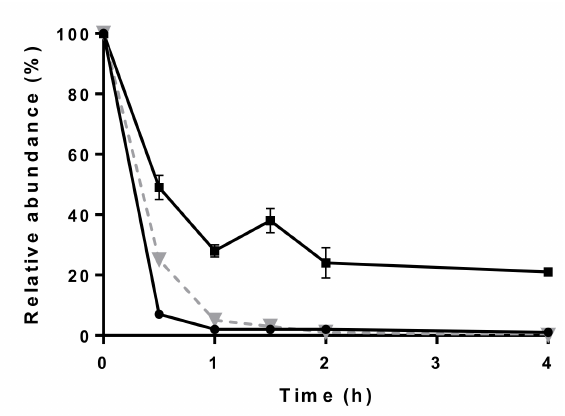
Figure 2. Degradation at room temperature (21 ± 2 ◦ C) over time of cefquinome (- (cid:72) -), ceftiofur ( • ) and desfuroylceftiofur ( (cid:4) ) in a 1000 ng g − 1 spiked fecal sample (mean ± standard deviation, n = 3, per time